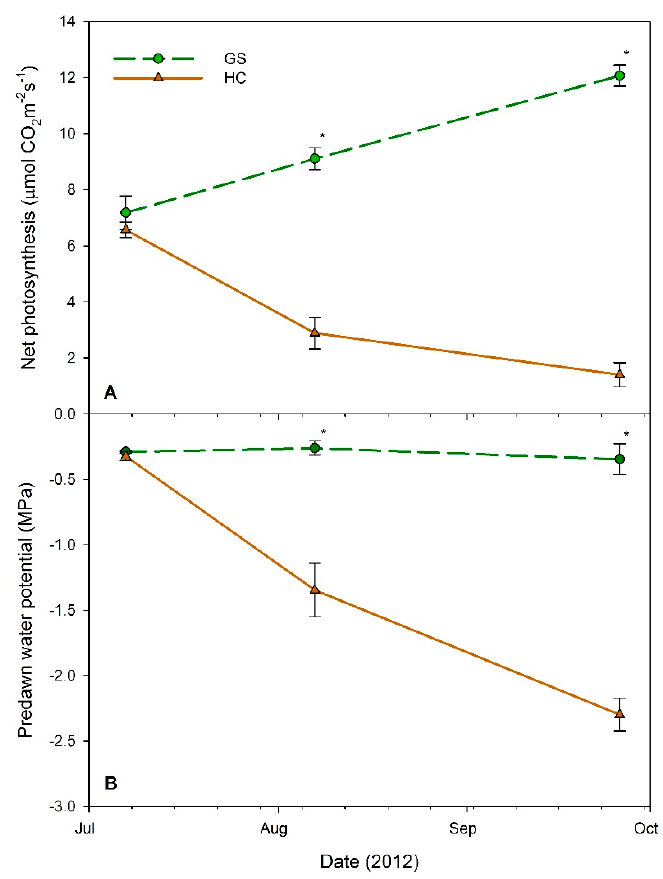
Figure 4. ( A ) Net photosynthesis and ( B ) predawn water potential of western larch seedlings at three measurement dates in 2012. Each point represents the mean ( n = 13–20) across all container sizes, within each vegetative treatment, high competition (HC: solid brown lines, triangles), and glyphosate sprayed (GS: dashed green lines, circles). Error bars represent the standard error of the mean. Points with asterisks (*) indicate a significant difference between HC and GS treatments for that date ( α = 0.05).